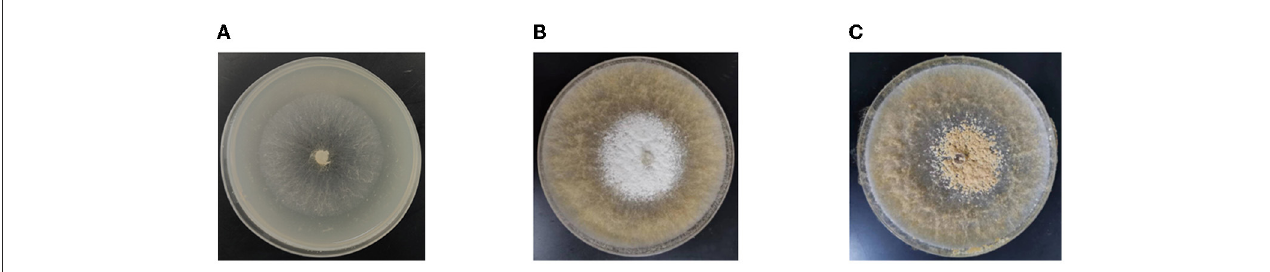
FIGURE1 Representative images of different development stages. (A) The growth stage of HG. (B) The growth stage of SD. (C) The growth stage of SM. HG is the period of early hyphae growth. SD is the period of sclerotium development. SM is the period of mature